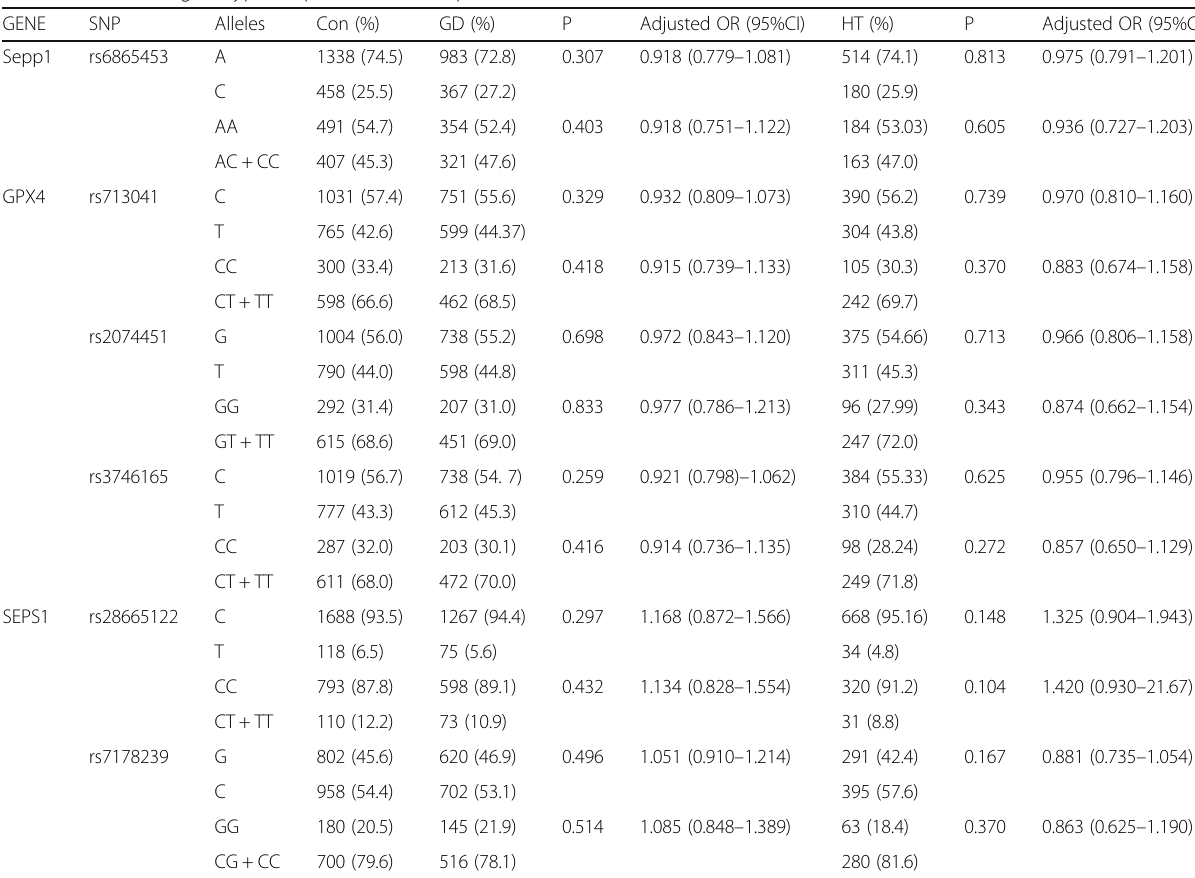
Table 3 Allele and genotype frequencies in AITD patients and controls